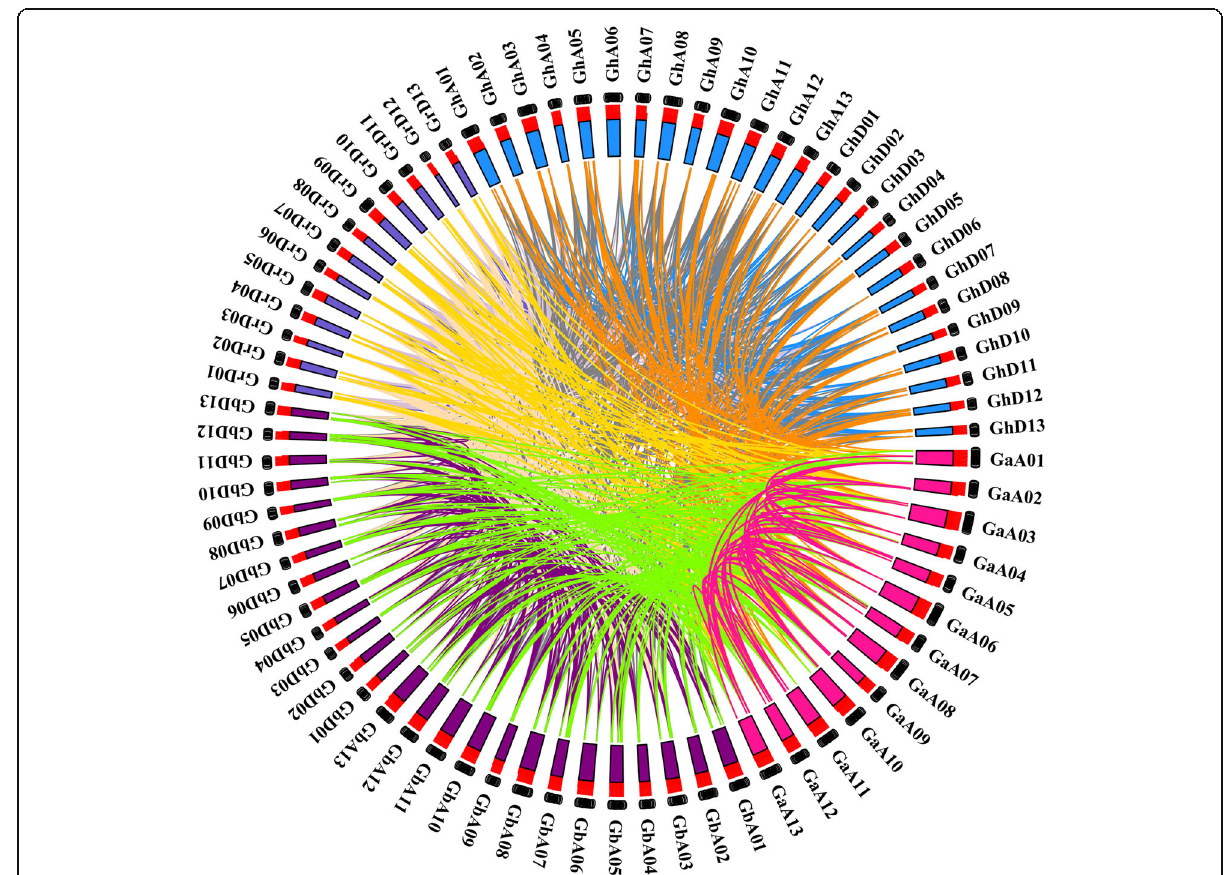
Fig. 6 Syntenic relationship of duplicated ZAT genes pairs from four Gossypium species ( G. hirsutum , G. barbadense , G. arboreum, and G. raimondii